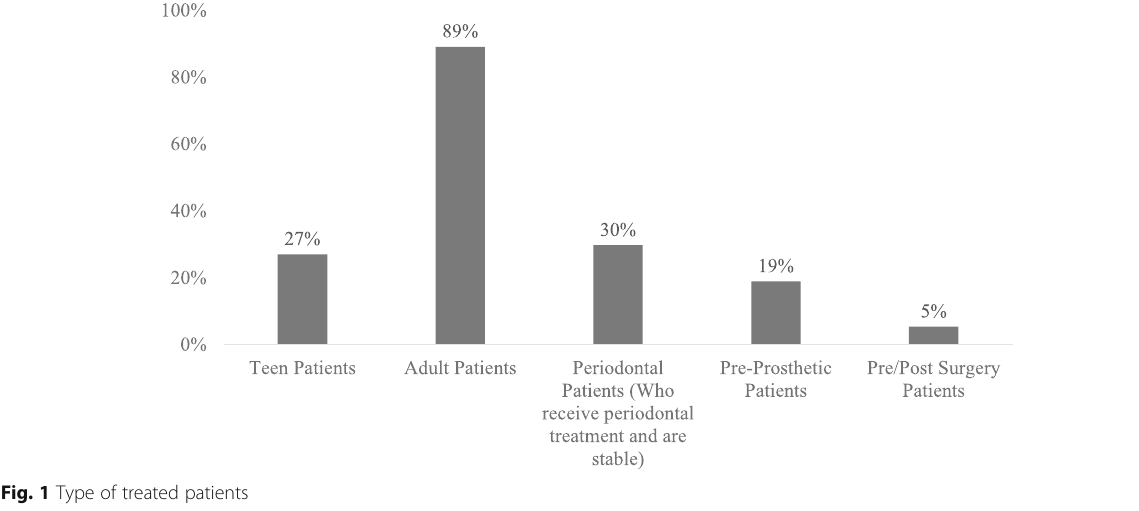
Table 5 Comparison between orthodontists and general dentists in malocclusion treatment Orthodontists (%) General dentists (%) P